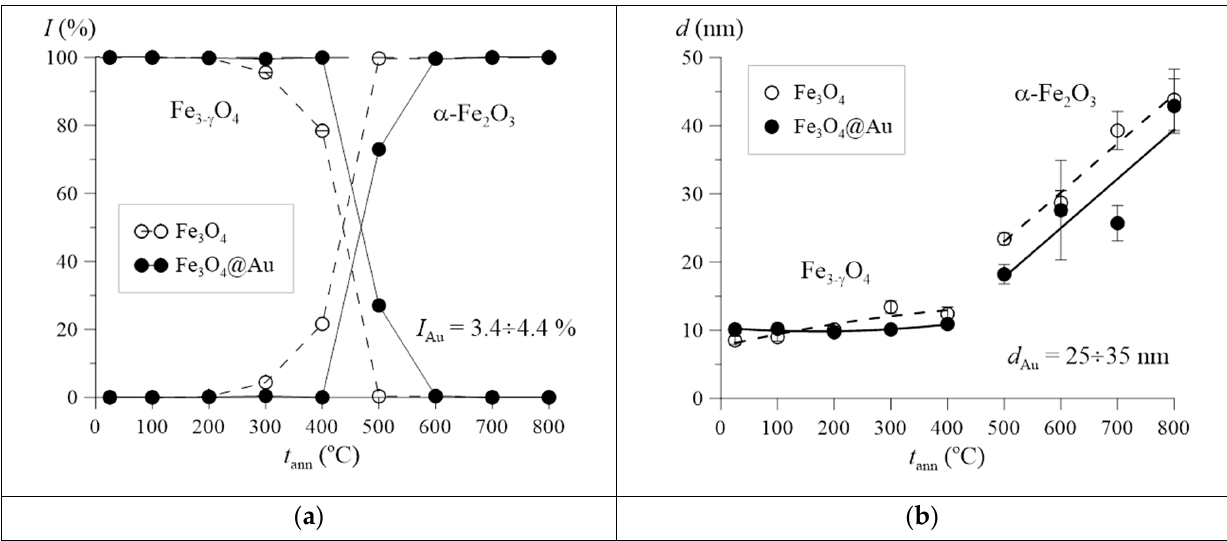
Figure 6. Dependences of relative intensities I of diffraction patterns of nonstoichiometric magnetite Fe 3 − γ O 4 and hematite α -Fe 2 O 3 ( a ), as well as the average size d of the regions of structural ordering of nanoparticles of nonstoichiometric magnetite Fe 3 − γ O 4 and hematite α -Fe 2 O 3 ( b ) on the annealing temperature t ann.